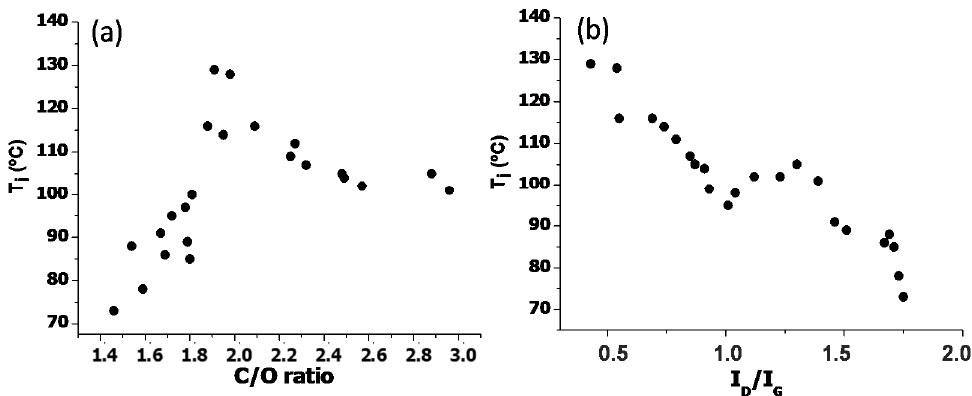
Figure 8. Initial degradation temperature (T i ) obtained at 2 wt% weight loss versus the C / O ratio ( a ) and the I D / I G band intensity ratio ( b ) for the synthesized EGOs.